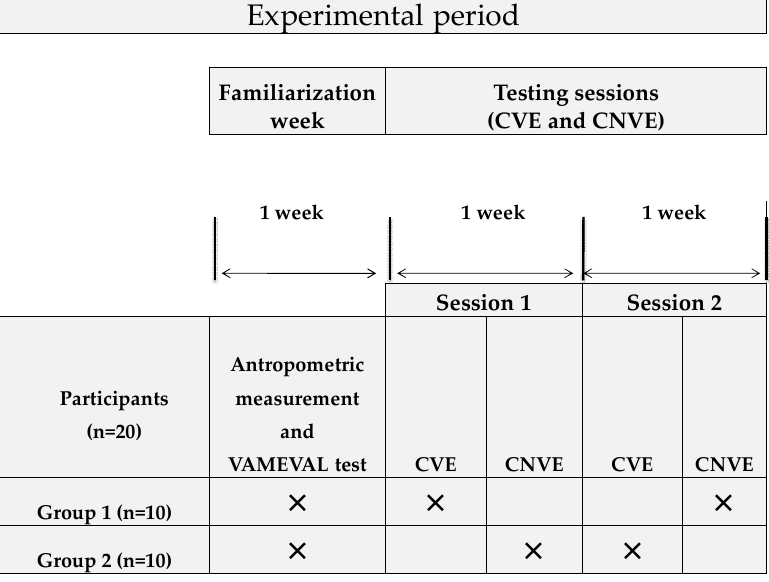
Figure 1. Representative diagram of the experimental protocol. n: number of participants; CVE: circuit exercise with verbal encouragement; CNVE: circuit exercise without verbal encouragement.